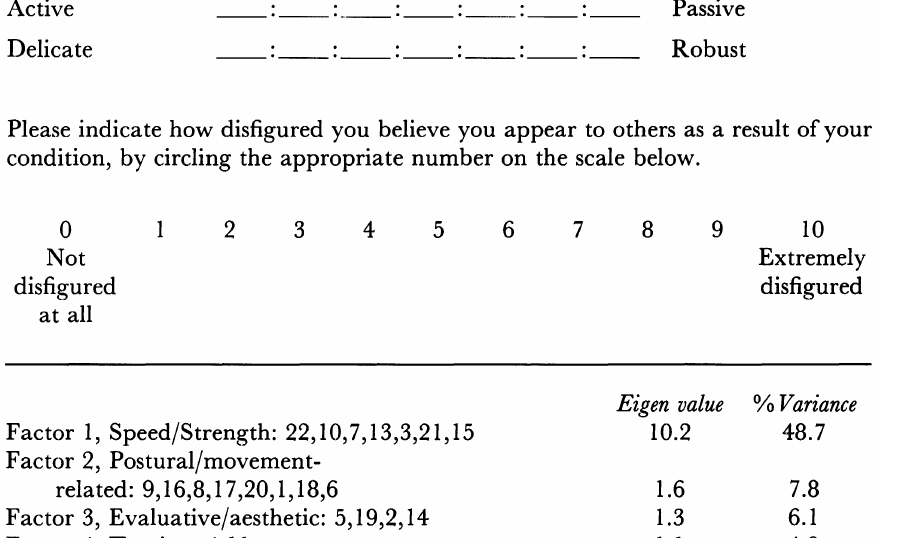
Con trolla ble Passive Robust